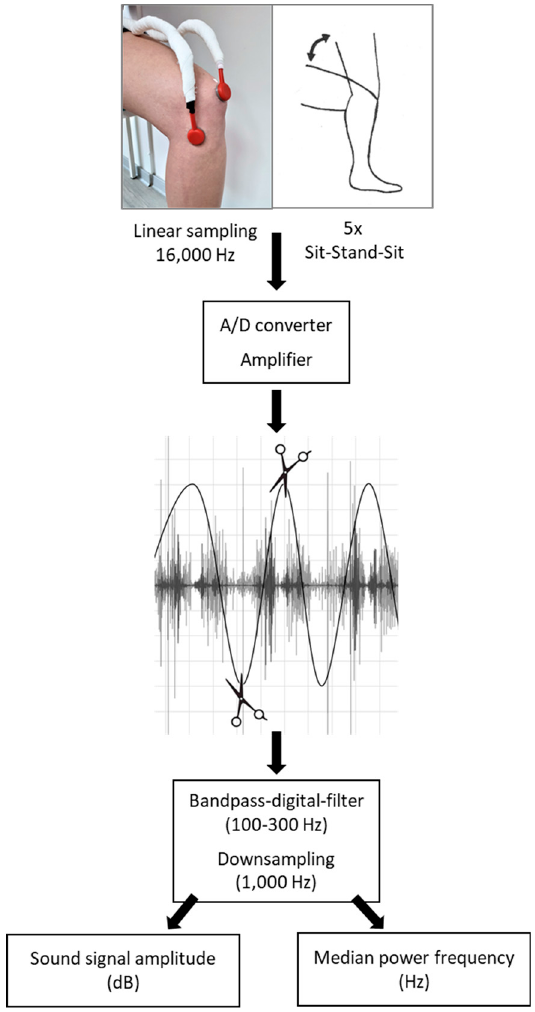
Figure 1. Sound data extraction and processing. A set consisted of five movement cycles (standing up and sitting down); data from the same movements were averaged. A/D: and sitting down); data from the same movements were averaged. A / D: analog digital analog digital converter.